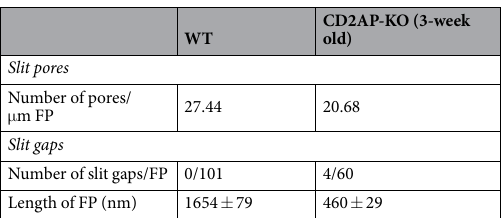
CD2AP-KO (3-week old)